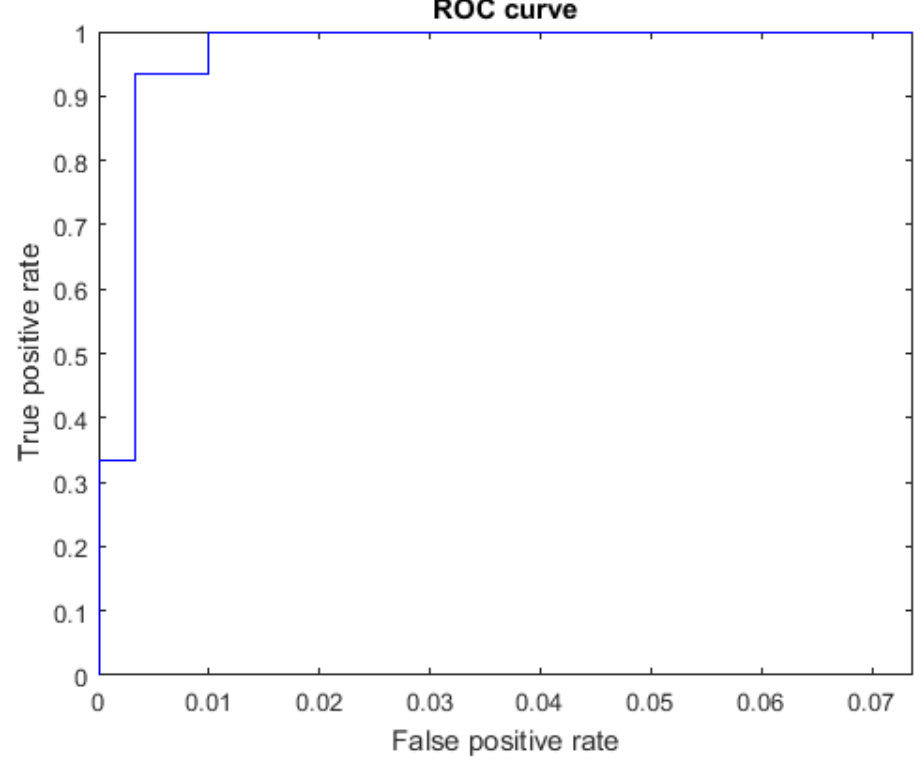
Figure 11. ROC curve for the letter T using spherical features, AUC = 0.9973.